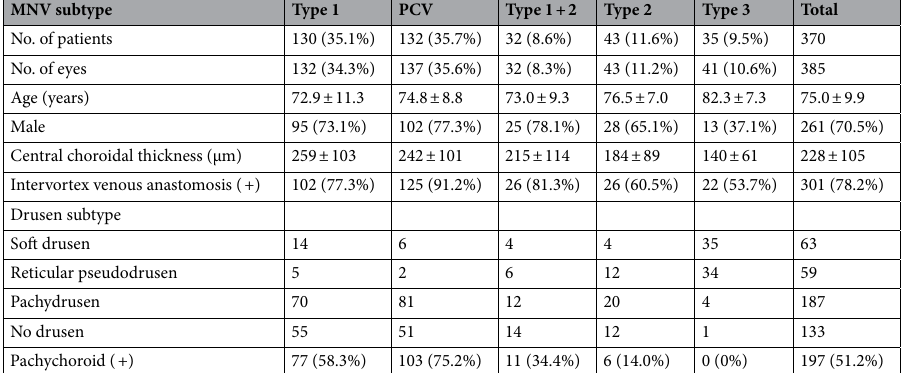
Table 1. Demographic and clinical characteristics of patients with neovascular age-related macular degeneration. MNV = macular neovascularization; PCV = polypoidal choroidal